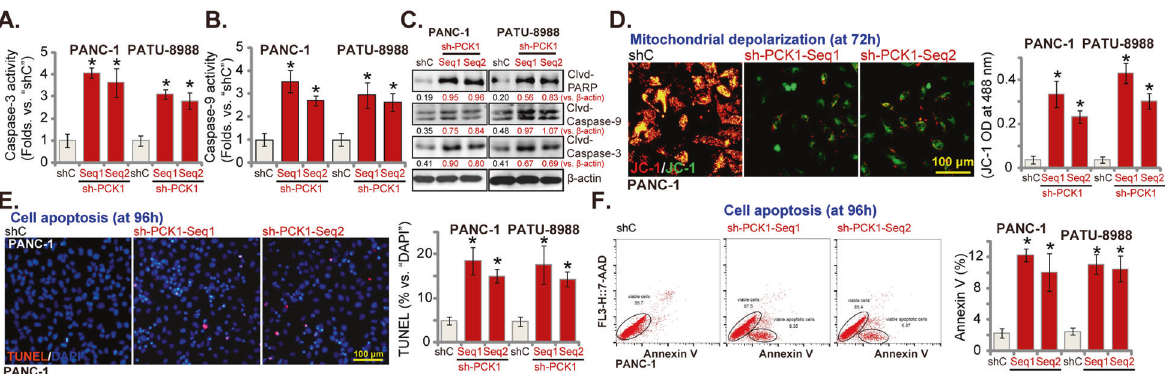
Fig. 3 PCK1 silencing provokes apoptosis activation in pancreatic cancer cells. Established human pancreatic cancer cell lines (PANC-1 and PATU-8988) ( A – F ), bearing the PCK1 shRNA ( “ sh-PCK1-Seq1 ” or “ sh-PCK1-Seq2 ” ) or lentiviral scramble control shRNA ( “ shC ” ), were established and cultured for applied time periods. Caspase-PAPR activations were tested by mentioned assays ( A – C ); Mitochondrial depolarization was tested by JC-1 staining assays ( D ), with cell apoptosis examined by nuclear TUNEL staining ( E ), and Annexin V-FACS assays ( F ), with results quanti fi ed. Data were presented as mean ± standard deviation (SD, n = 5). * P < 0.05 vs. “ shC ” cells. The experiments were repeated fi ve times with similar results obtained. Scale bar = 100 μ m ( D , E ).